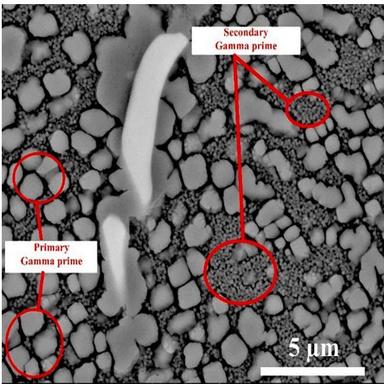
SEM micrograph of the unexposed GTD-111 microstructure including γ́ distribution (primary and secondary).